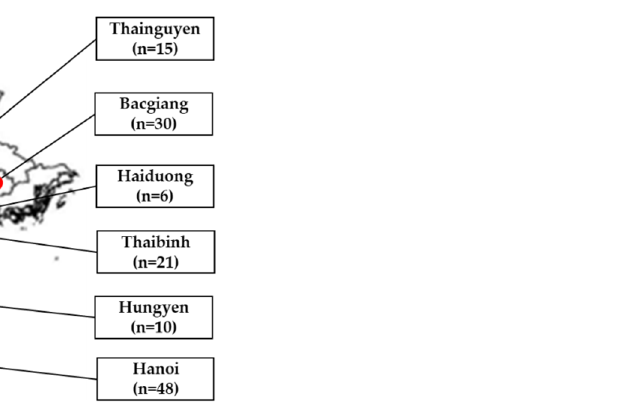
Figure 1. Geographical locations of sample areas in northern Vietnam (red circles) and distribution of sampling size in Thainguyen (15), Bacgiang (30), Haiduong (6), Thaibinh (21), Hungyen (10), and Hanoi (48). Table 1. Primers used in this